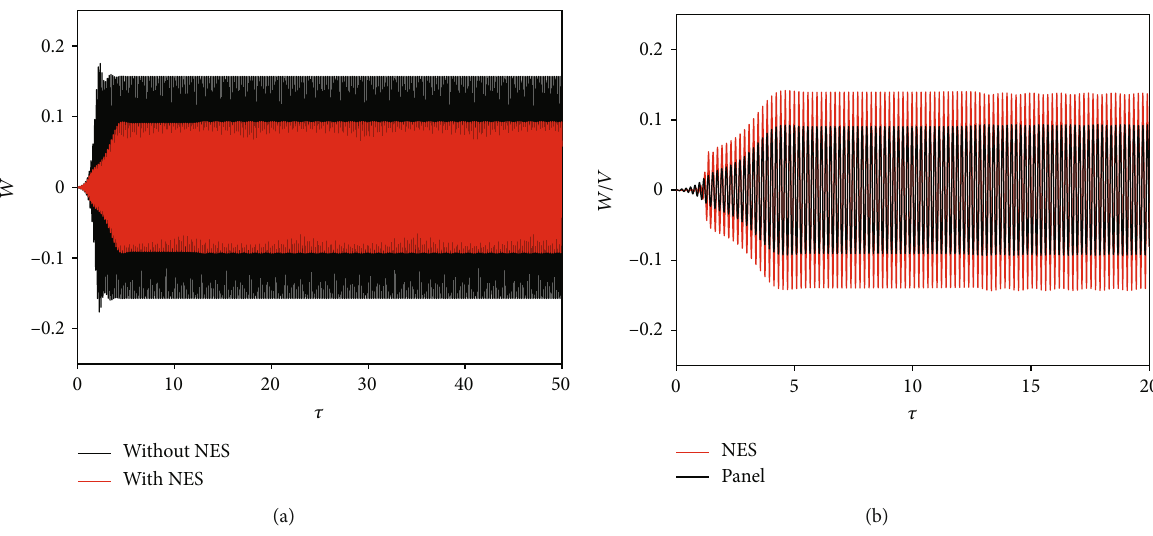
Figure 11: Time history at λ = 370 : (a) responses of the panel with and without an NES; (b) responses of the NES and